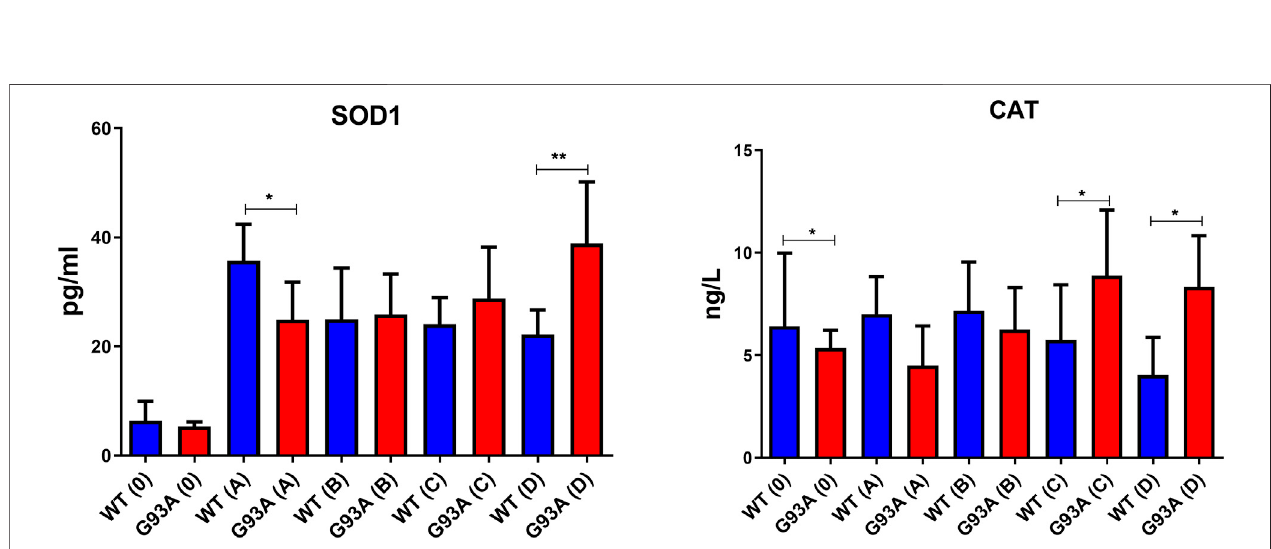
FIGURE 9 | SOD1 and CAT levels in the cytosol of lung tissues belonging to both SOD1 WT (WT) and SOD1 G93A (G93A) samples were evaluated via ELISA assay. Data were given as mean ± SD of n = 8 animals for each group. Notes: * p ≤ 0.05, ** p ≤ 0.001 and *** p ≤ 0.000.1.